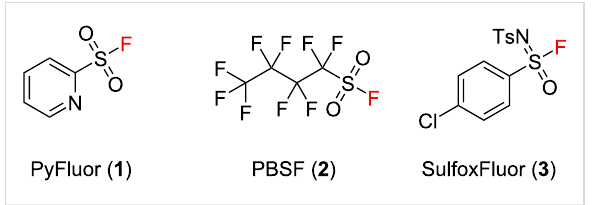
Figure 1: Chemical structure of PyFluor, PBSF and SulfoxFluor.